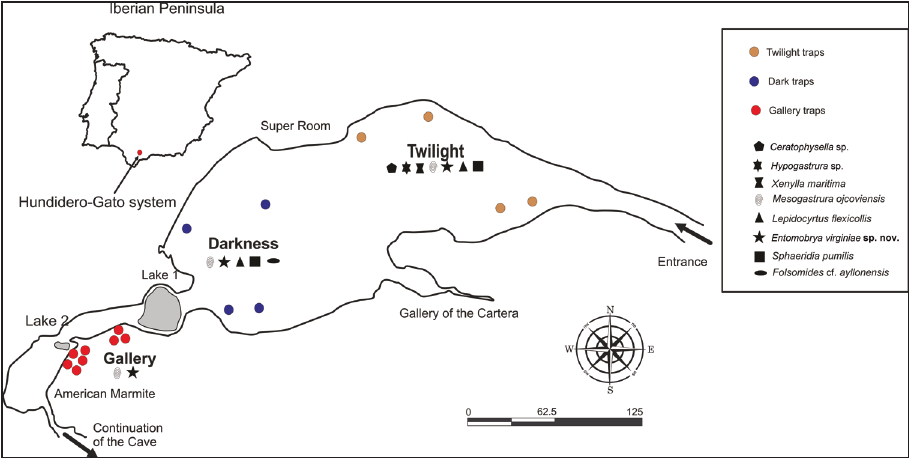
Figure 1. Topography of Hundidero-Gato system and locations where the Collembola were sampled. Modified from Guerrero Sánchez (2015). In brown, the twilight pitfall traps, in blue, the darkness pitfall traps and in red, gallery traps (five on guano and three on ground without guano). The different species that appear in each area are represented with their own symbol in the